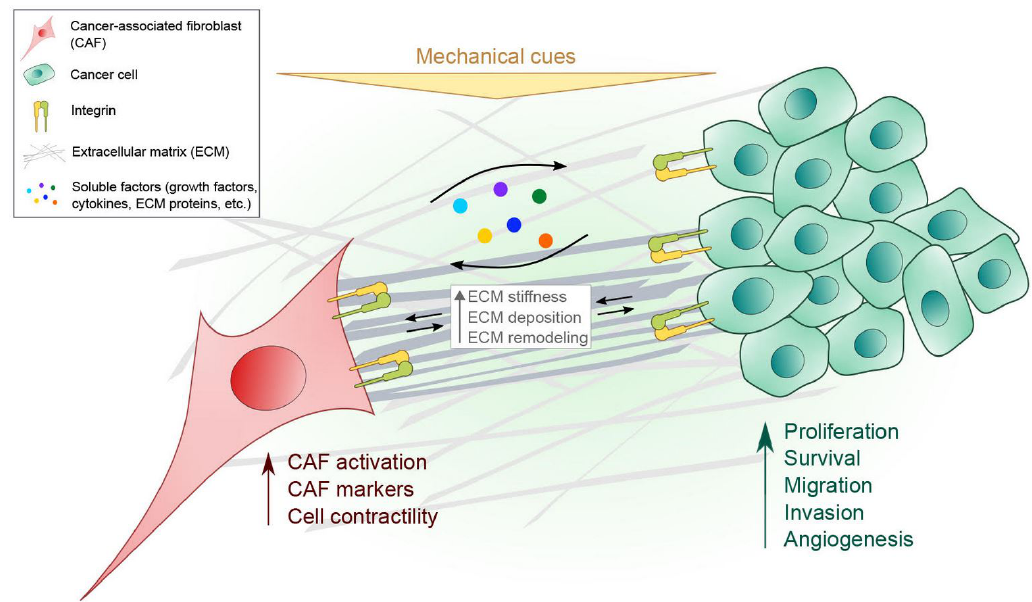
Figure 1. Interplay between CAFs and cancer cells in the TME. Multiple types of integrins (shown as one type for simplification in the figure) on CAFs and cancer cells are responsible for sensing and transducing various protein such as ECM proteins and mechanical cues (e.g., substrate rigidity, hydrostatic pressure, compressive, tensile and shear stress) present in the TME. See Table 1 for details regarding di ff erent integrin subtypes and their ligands in cancer progression. Signals arising from enhanced ECM sti ff ness, for example, can also be recognized by both CAFs and cancer cells through integrins. CAFs and cancer cells also influence each other’s physiological processes by releasing and receiving diverse soluble factors in a paracrine